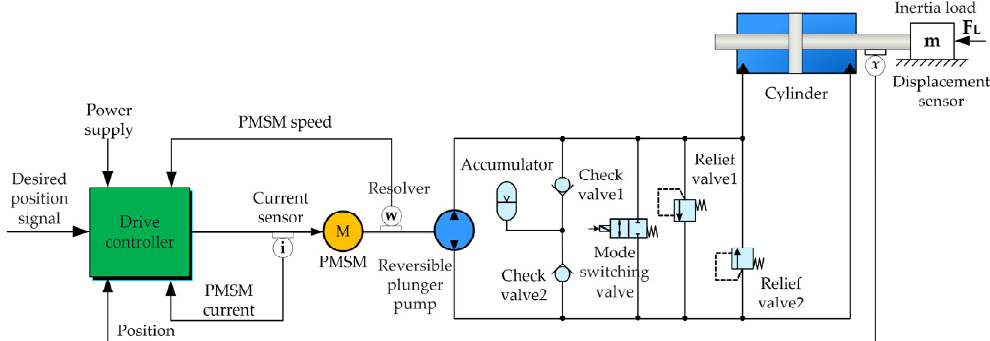
Figure 1. Schematic diagram of